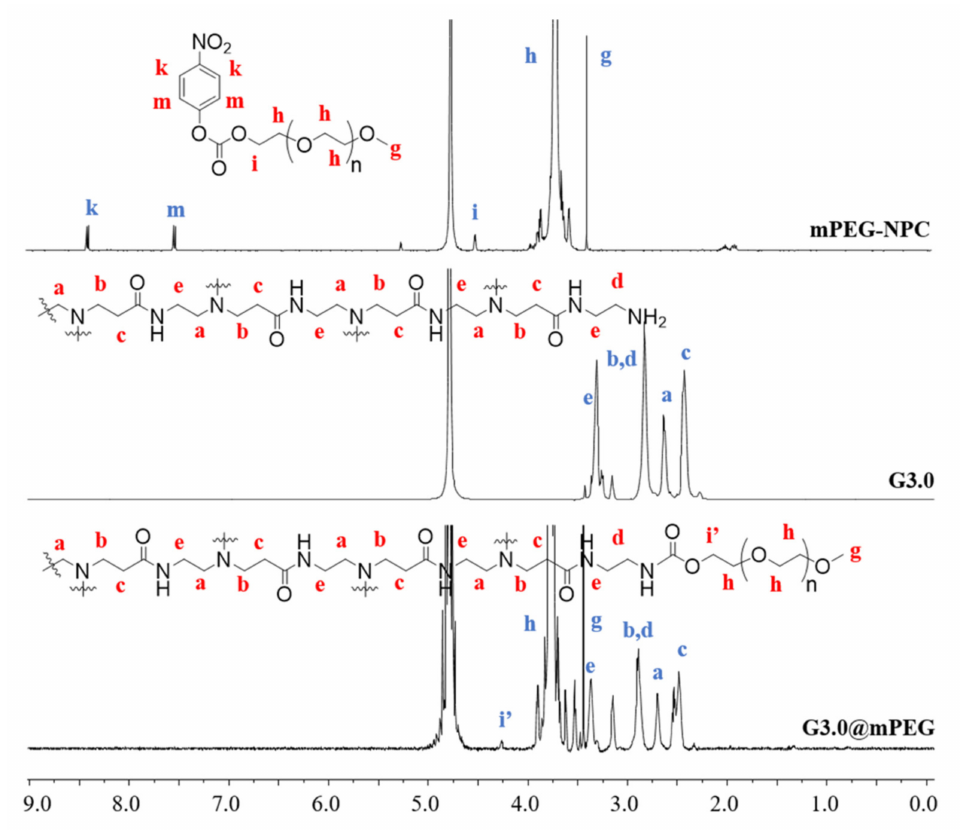
Figure 1. 1 H-NMR spectrum of G3.0@mPEG, G3.0 and mPEG-NPC. The lowercase Roman letters indicate protons with respective